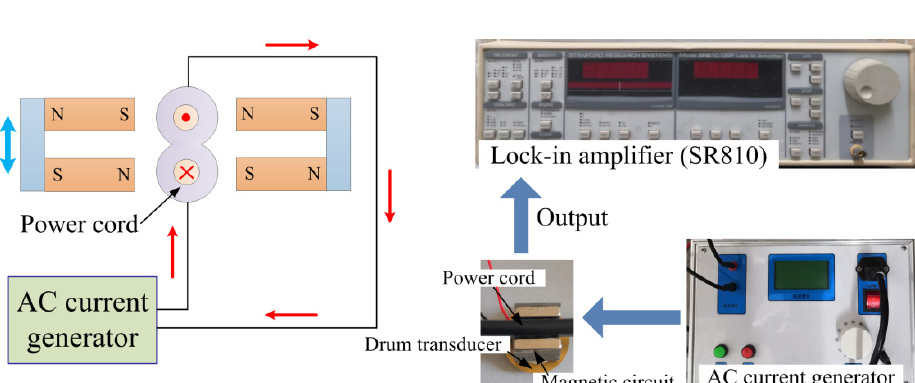
Figure 4. Experimental set-up for 50 Hz current sensing experiments.